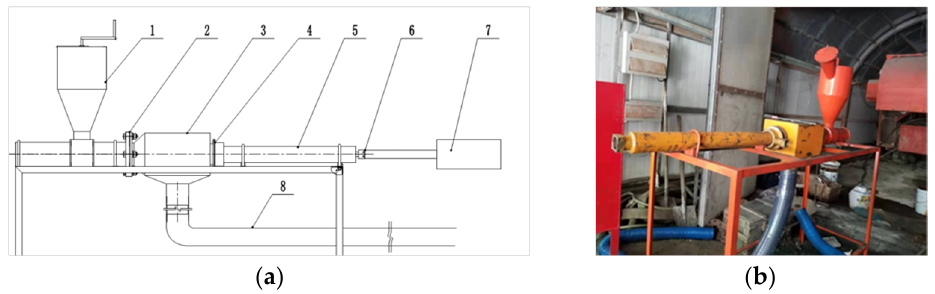
Figure 5. Dust hood testing system: ( a ) cross-section of the product: 1—screw-driven dust-generating device; 2—sealing pipeline; 3—dust hood; 4—dust control device; 5—drill pipe; 6—KJ25 interface; 7—air compressor; 8—dust collection pipe; ( b ) real product.